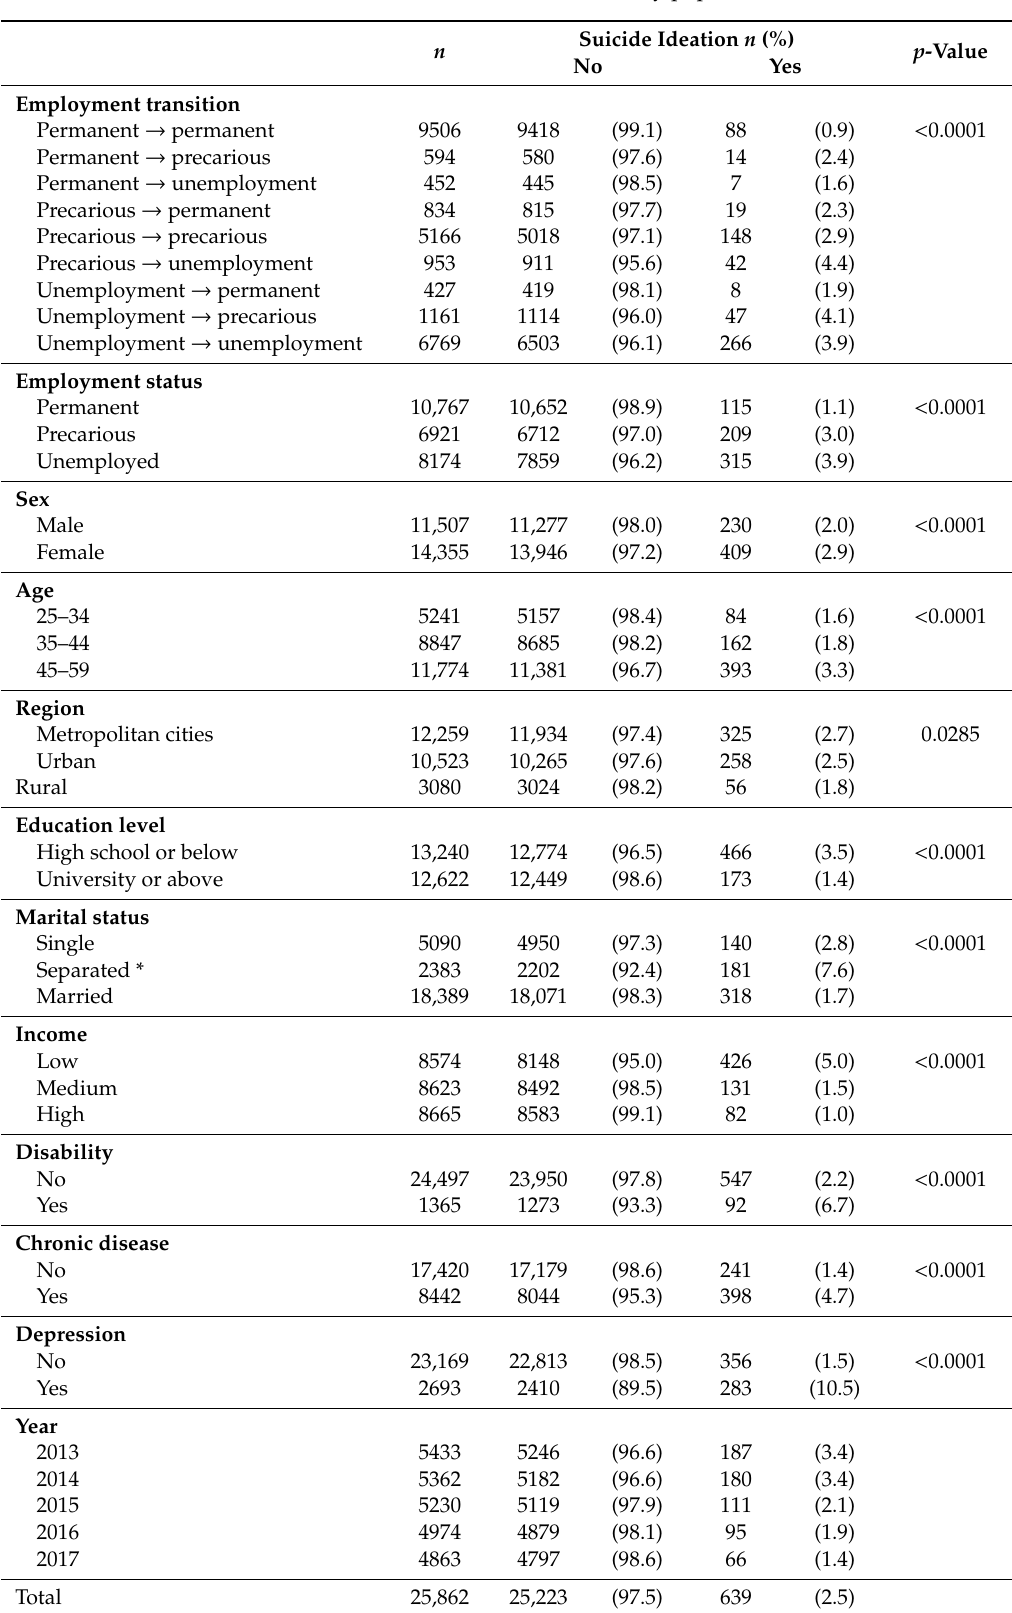
Table 1. General characteristics of the study